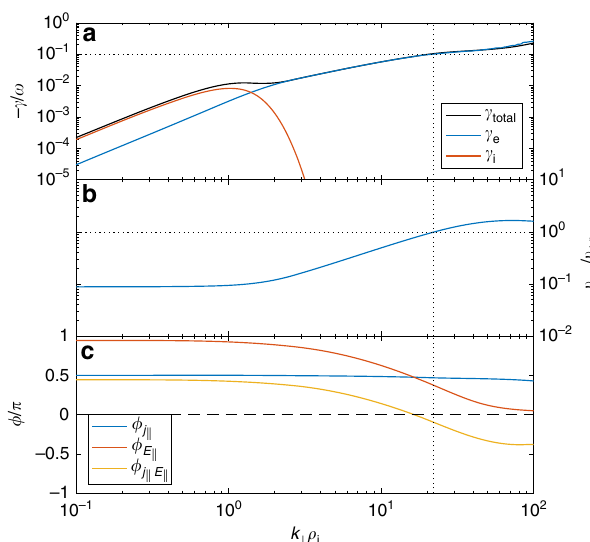
Fig. 3 Numerical linear kinetic Alfvén wave (KAW) solutions. a Damping rates, b resonant velocity, and c phase angles for the KAW for the measured parameters. The dotted lines mark where the damping becomes strong (cid:3) γ = ω (cid:4) 0 : 1